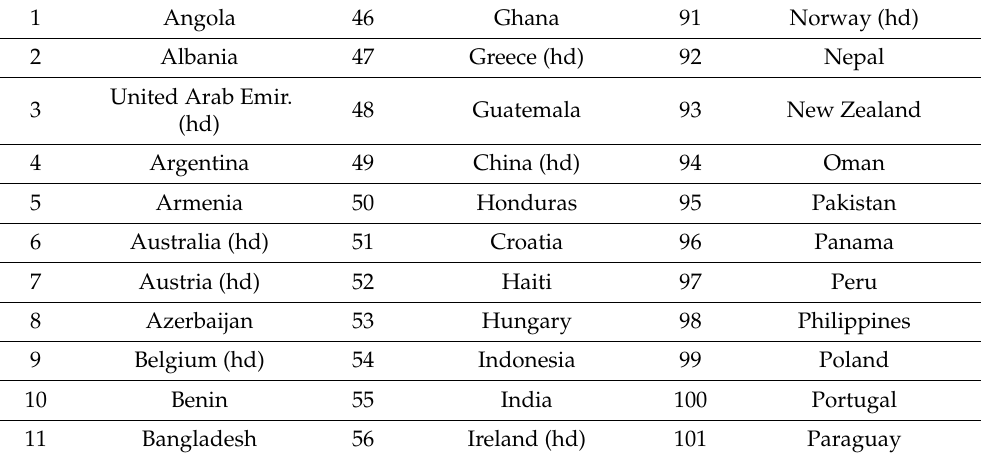
Table A1. Countries considered in the analysis; “hd” in brackets indicates highly developed